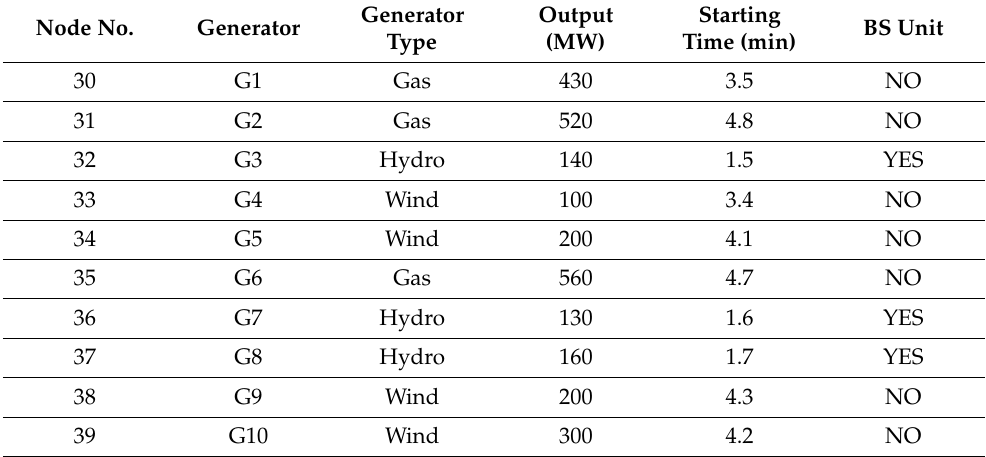
Table 7. Data generators for the IEEE-39 bus system and its classification. Node